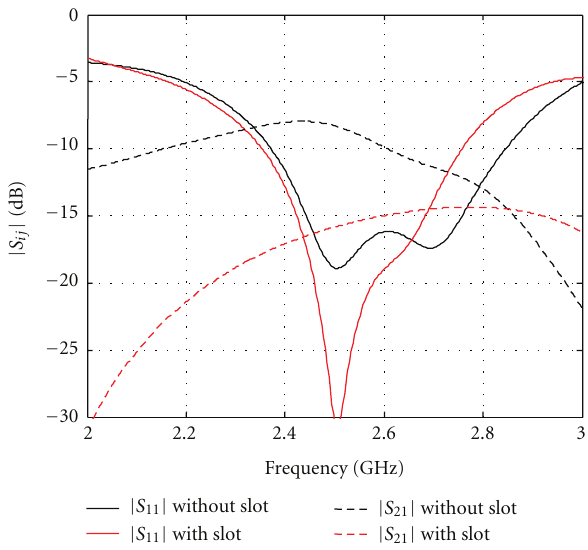
Figure 4: Simulated | S 11 | parameters of one and three meander bend endings antennas with added ground plane and slot in the lower